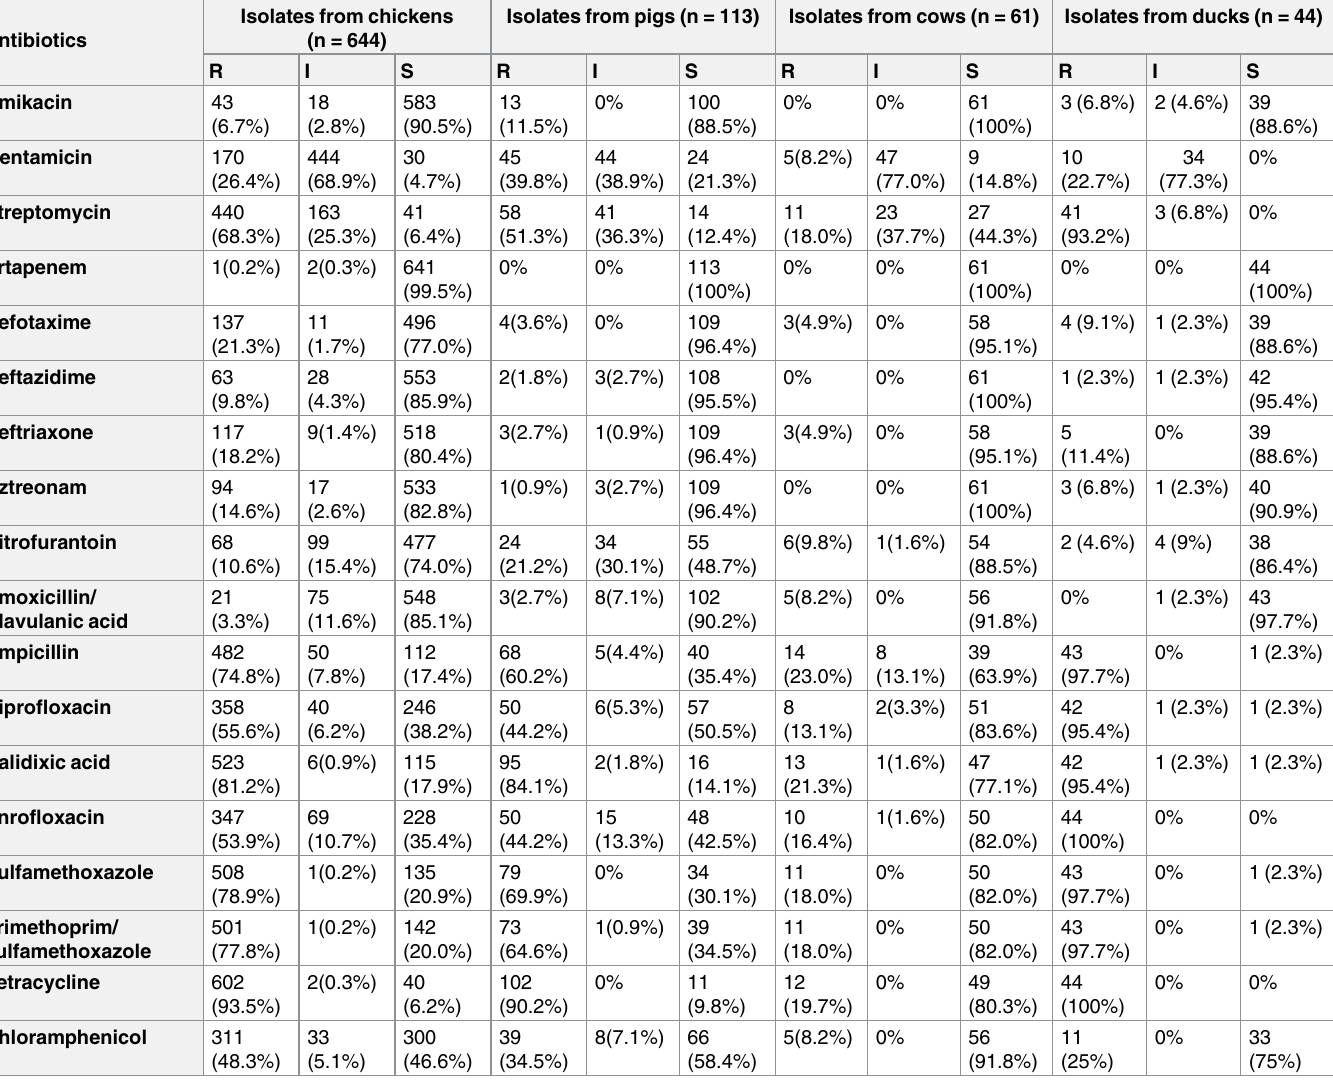
Table 1. Percentage of antimicrobial resistance among Escherichia coli isolates. Isolates from chickens Antibiotics (n =